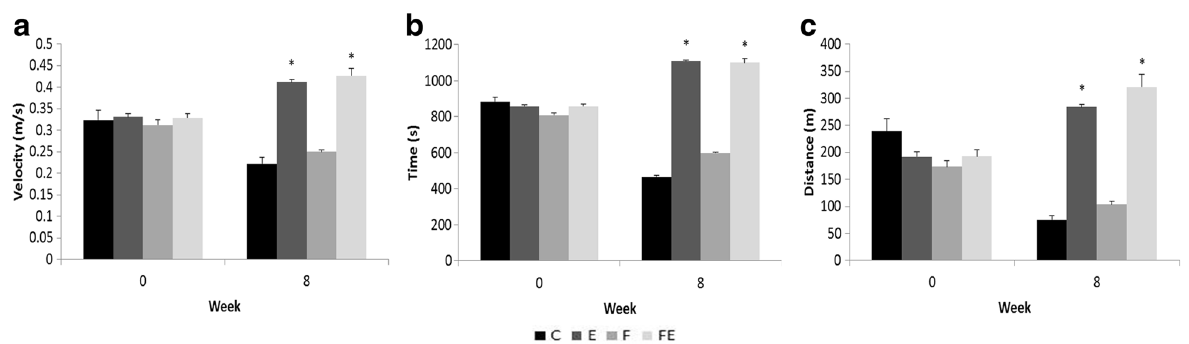
Fig. 1 Maximal exercise capacity before (week 0) and after (week 8) 8 weeks of treadmill training or fructose ingestion. Groups: C control, E exercise, F fructose, FE fructose + exercise. Results are presented as mean±SEM. a Velocity. b Duration of exercise. c Traveled distance. Exercised animals (E and FE) displayed higher exercise capacity than their non-exercised littermates (* p <0.001) after 8 weeks in all parameters. E and FE rats also improved their